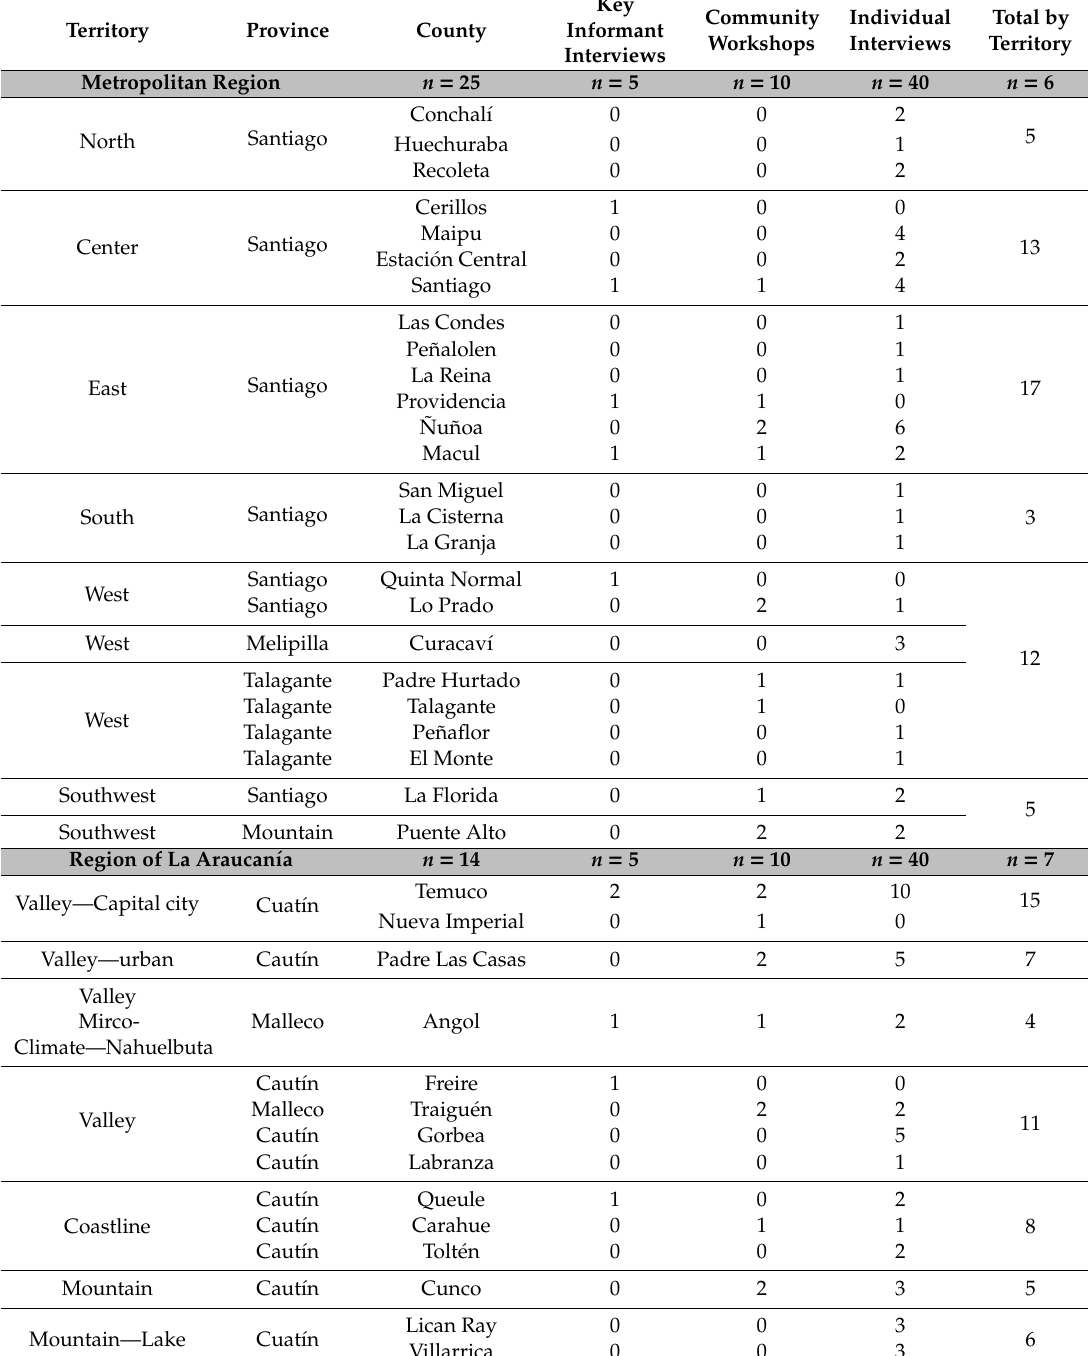
Table 3. Study site territorial distribution overview by